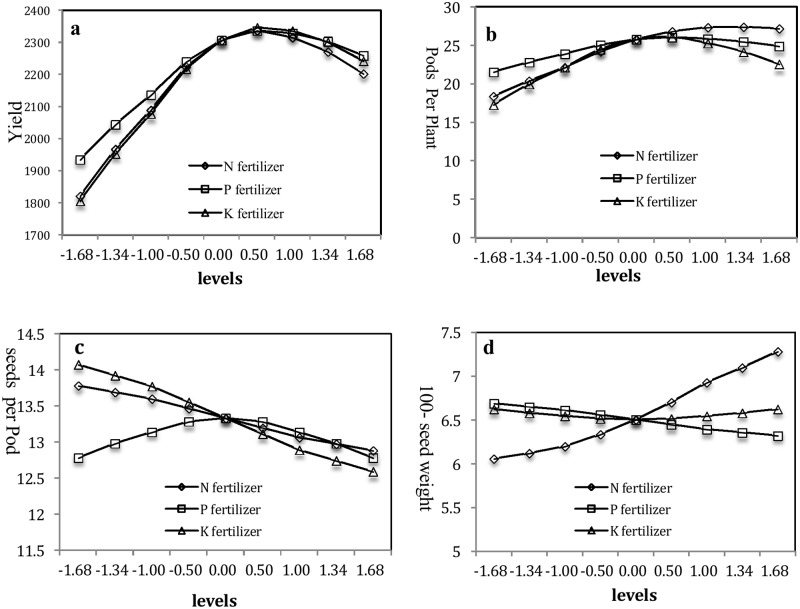
Effect of N, P, and K fertilizers on yield and yield components.a. Effects of N, P, and K fertilizers on yield when N(X1) was within (-1.68, 1.68), Y = 2,306.85 + 113.22X1−104.14X12. When P(X2) was within (-1.68, 1.68), Y = 2306.85 + 96.50X2−74.09X22. When K(X3) was within (-1.68, 1.68), Y = 2306.85 + 129.66X3−99.92X32. b. Effects of N, P, and K fertilizers on pods per plant. When N(X1) was within (-1.68, 1.68), Y = 25.81 + 2.61X1−1.06X12. When P(X2) was within (-1.68, 1.68), Y = 25.81 + 0.99X2−0.91X22. When K(X3) was within (-1.68, 1.68), Y = 25.81 + 1.57X3−2.07X32. c. Effects of single-factor N, P, and K fertilizer on the seeds per pod. When N(X1) was within (-1.68, 1.68), Y = 13.34–0.27X1 + 0.11X12. When P(X2) was within (-1.68, 1.68), Y = 13.34–0.15X2−0.19X22. When K(X3) was within (-1.68, 1.68), Y = 13.34–0.44X3−0.15X32. d. Effects of N, P, and K fertilizers on 100-seed weight. When N(X1) was within (-1.68, 1.68), Y = 6.51 + 0.36X1 + 0.06X12. When P(X2) was within (-1.68, 1.68), Y = 6.51–0.11X2 + 0.02X22. When K(X3) was within (-1.68, 1.68), Y = 6.51–0.01X3 + 0.04X32.